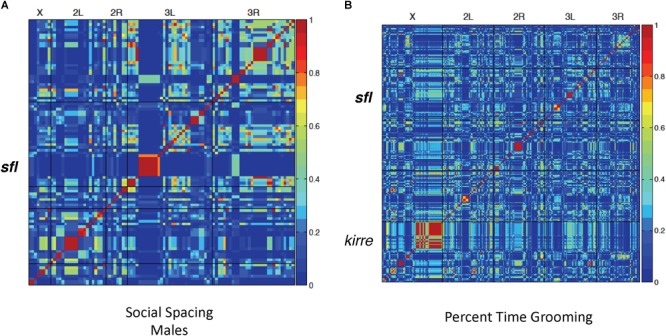
Linkage disequilibrium heatmaps, social spacing and grooming. LD mapping for 40 DGRP lines in both the social interaction (spacing) and grooming tests. Red areas indicate significantly associated variants. (A) Using the social spacing triangle, the average distance among flies was measured. The average value for three runs was used for LD mapping for 40 lines using the online GWAS tool (http://dgrp2.gnets.ncsu.edu/). (B) Total time grooming was measured for each of 40 DGRP lines in three separate runs and the average value used for LD mapping for 40 lines using the online GWAS tool (http://dgrp2.gnets.ncsu.edu/). In both social spacing tests and grooming tests there was a significant association between SNPs in or around sfl and the behavior being measured.